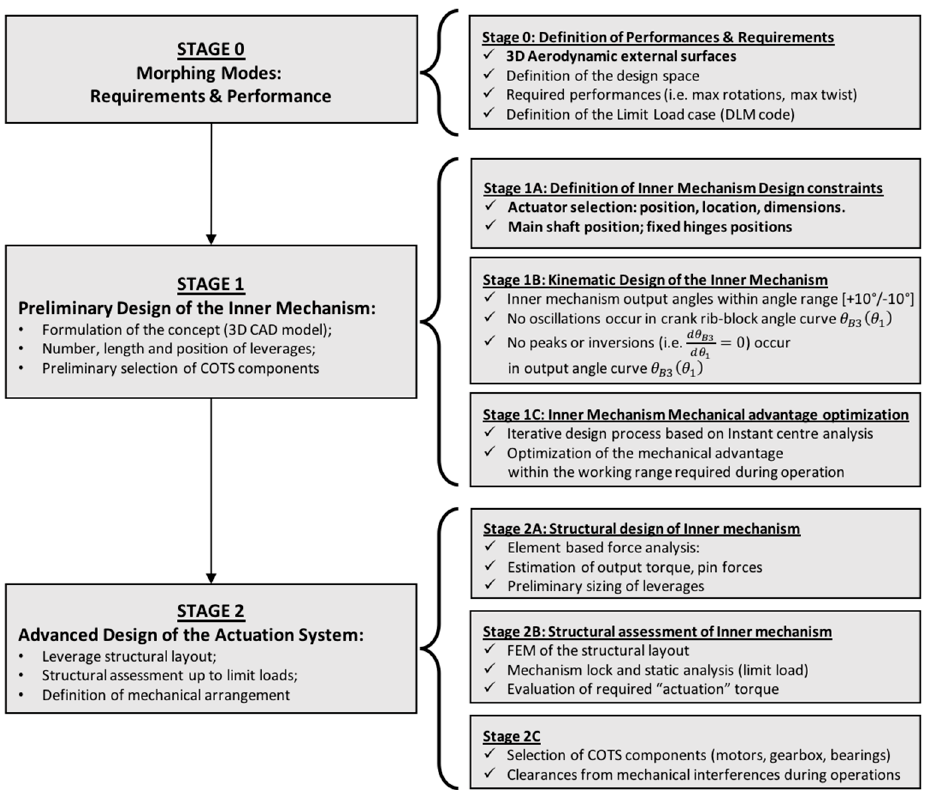
Figure 7. Flow-chart of the actuation system design process.